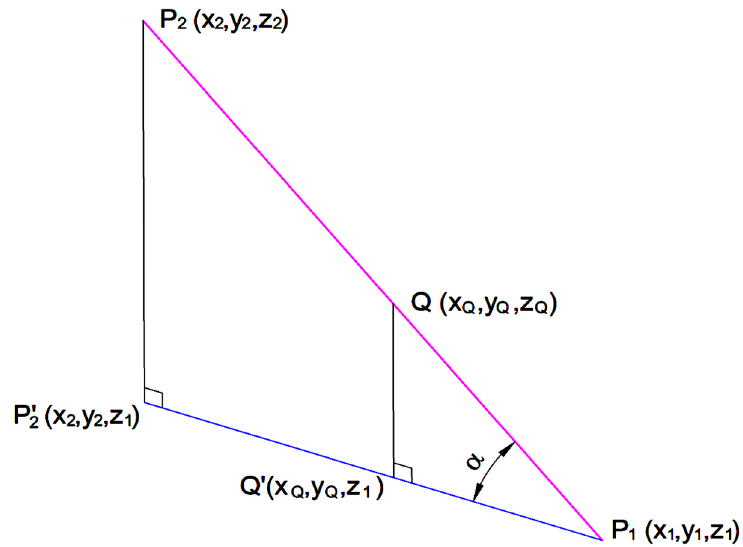
Figure 2. Determining the slope at Q using P 1 and P 2 .